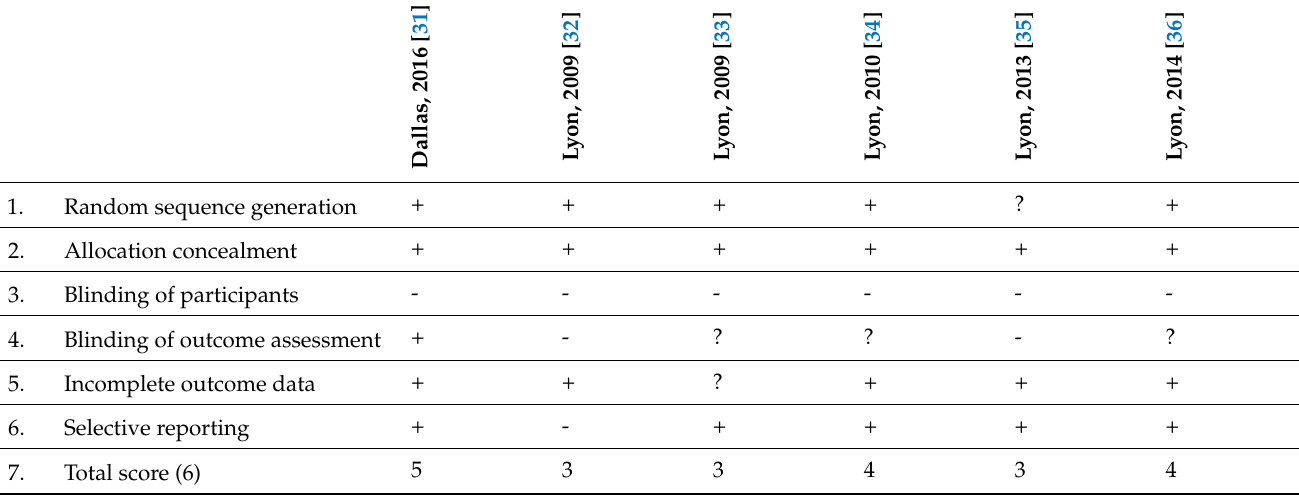
Table A1. Risk of bias assessment trials according to Cochrane risk of bias tool.